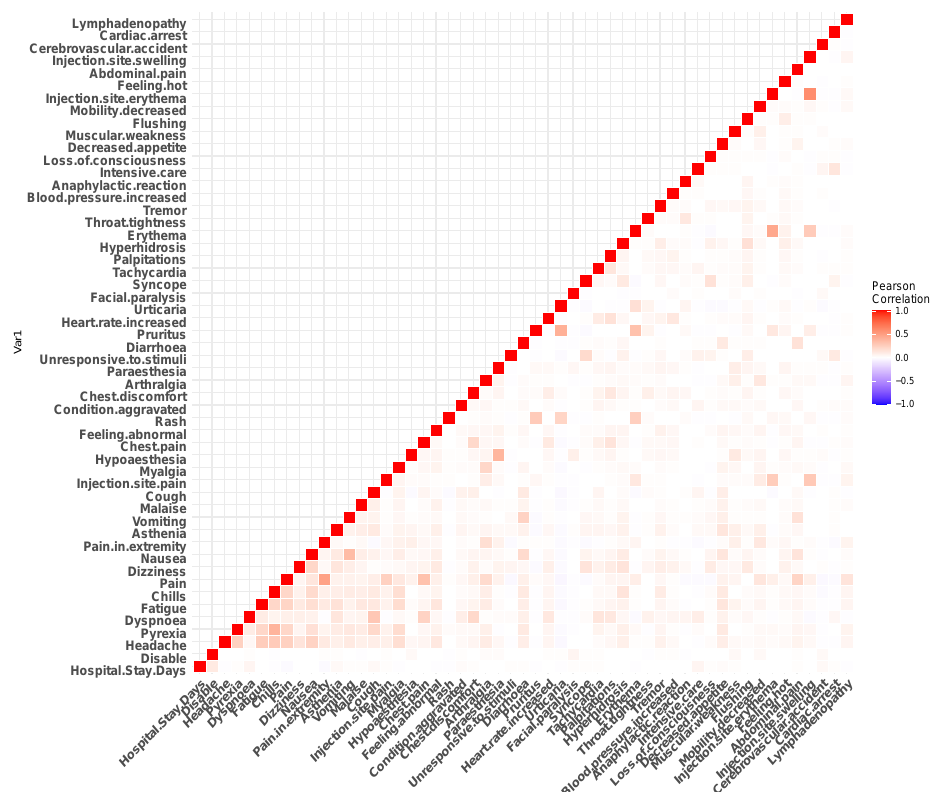
Figure 3. Pearson’s correlation heat-map for the dataset adverse